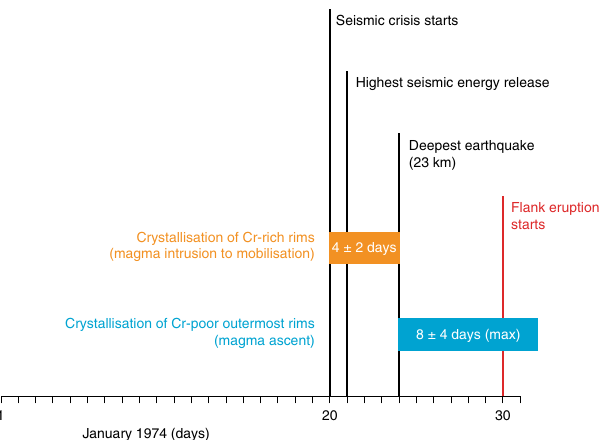
Fig. 6 Recharge to eruption clinopyroxene timescales compared to pre- eruptive seismic events for the 1974 eccentric eruption. The horizontal axis represents calendar days in January 1974. Major seismic events preceding the onset of eruption 23,45 are marked with vertical lines. Average growth times of clinopyroxene rims and outermost rims for this eruption (Fig. 5) are represented by horizontal rectangles. The 1974 eruption is related to one of the greatest seismic crises ever registered on Mt. Etna. We interpret that seismicity started due to magma intrusion, recorded by the crystallisation of Cr-rich rims. Magma mobilisation fi ts the timing of the deepest earthquake, and ascent to the surface is recorded by Cr-poor outermost